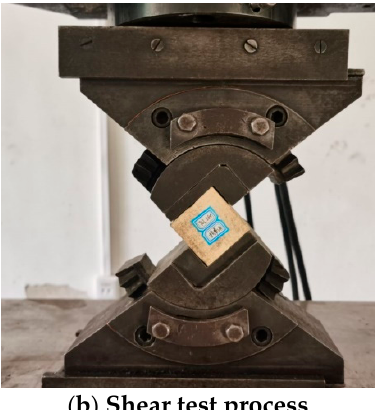
Figure 5. Shear test instrument and process.